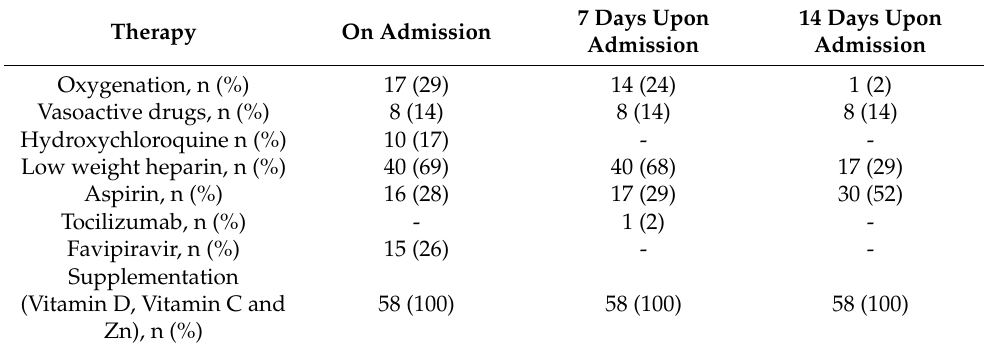
Table 2. Administrated therapy in the cohort of COVID-19 patients over the course of the disease. 7 Days Upon 14 Days Therapy On Admission